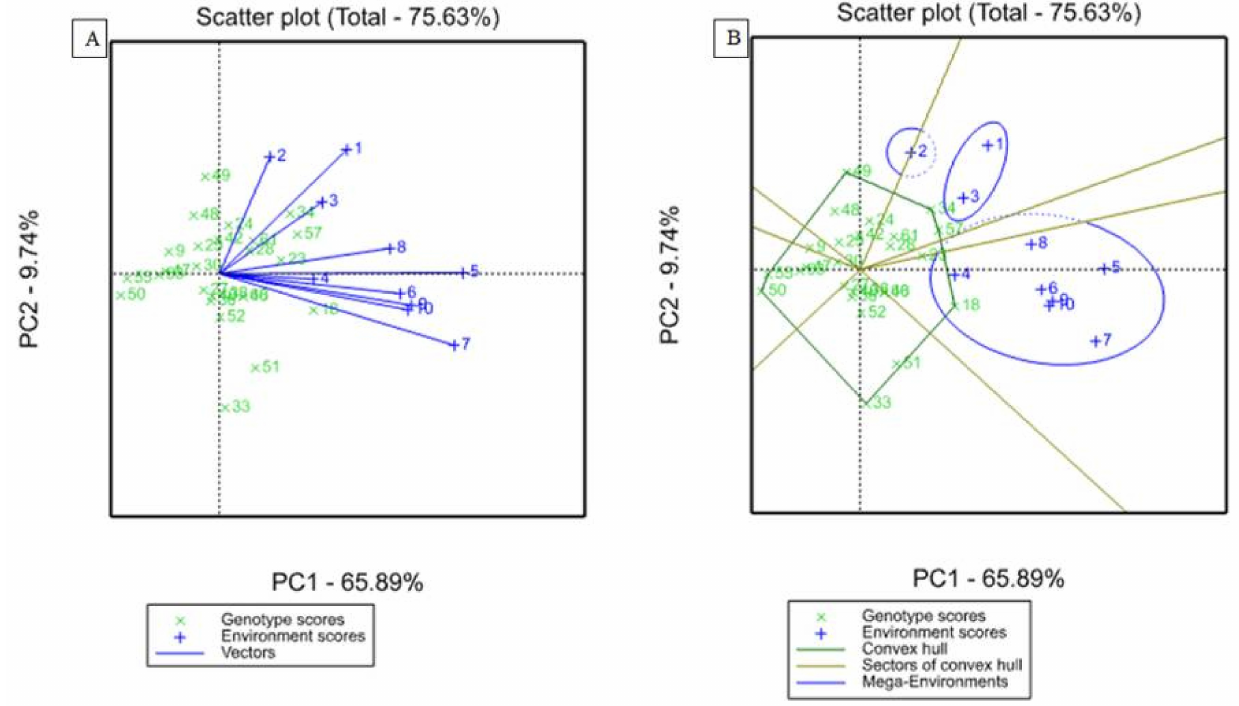
Figure 4. Biplots showing the positions of inbred lines and environments on the scatter-gram. ( A ) A GGE scatter biplot (environment scaling) showing the position of environments and genotypes on the biplot, ( B ) A GGE biplot showing mega environments depicted by foliar fall armyworm damage scores of 26 maize genotypes evaluated across ten environments in Zimbabwe during resent genotypes evaluated, the numbers correspond to the genotype codes in Table 5. Environ- ments: +1 = Harare-DR&SS-2019; +2 = Harare-CIMMYT-2019; +3 = Harare-Managed